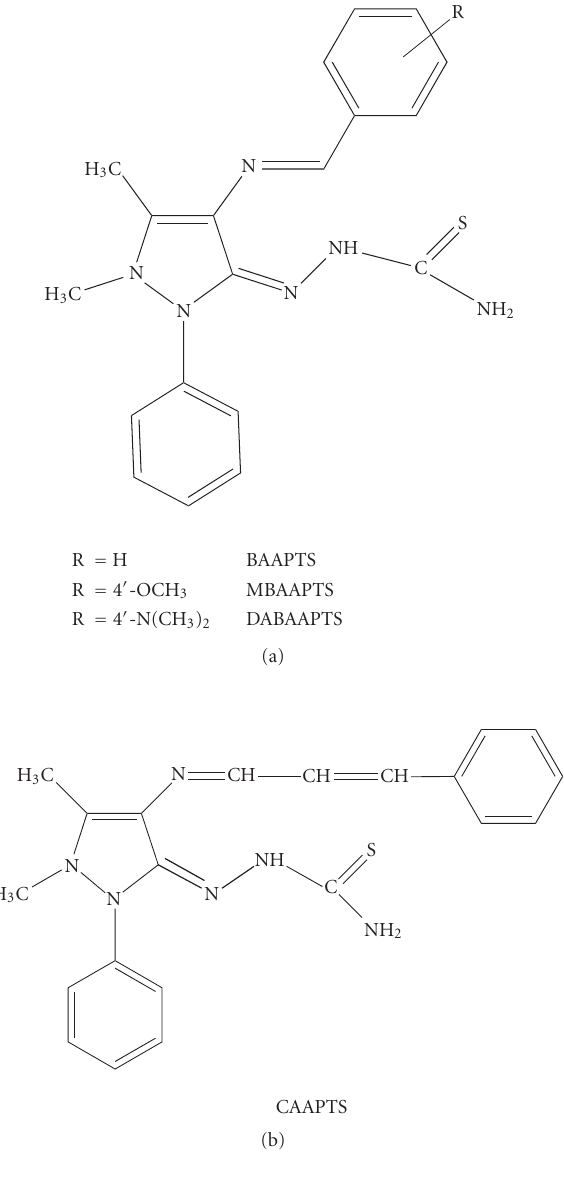
Figure 1: Structures of di ff erent thiosemicarbazones.